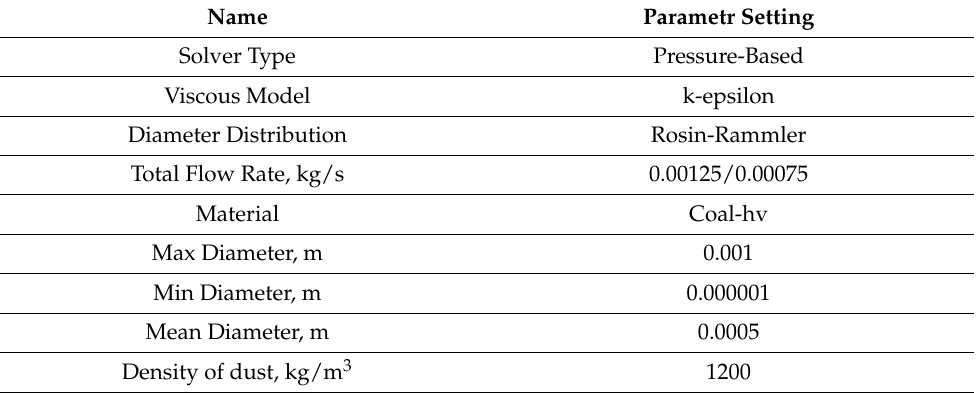
Table 1. The major parameter setting.